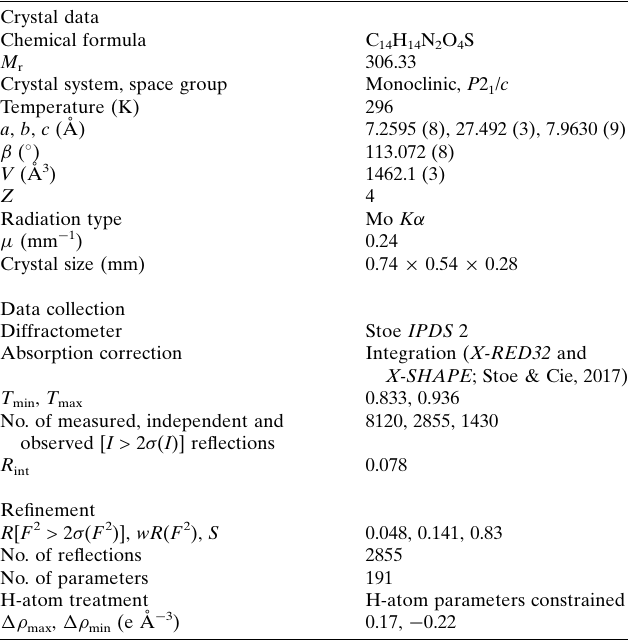
Table 2 Experimental details. Crystal data Chemical